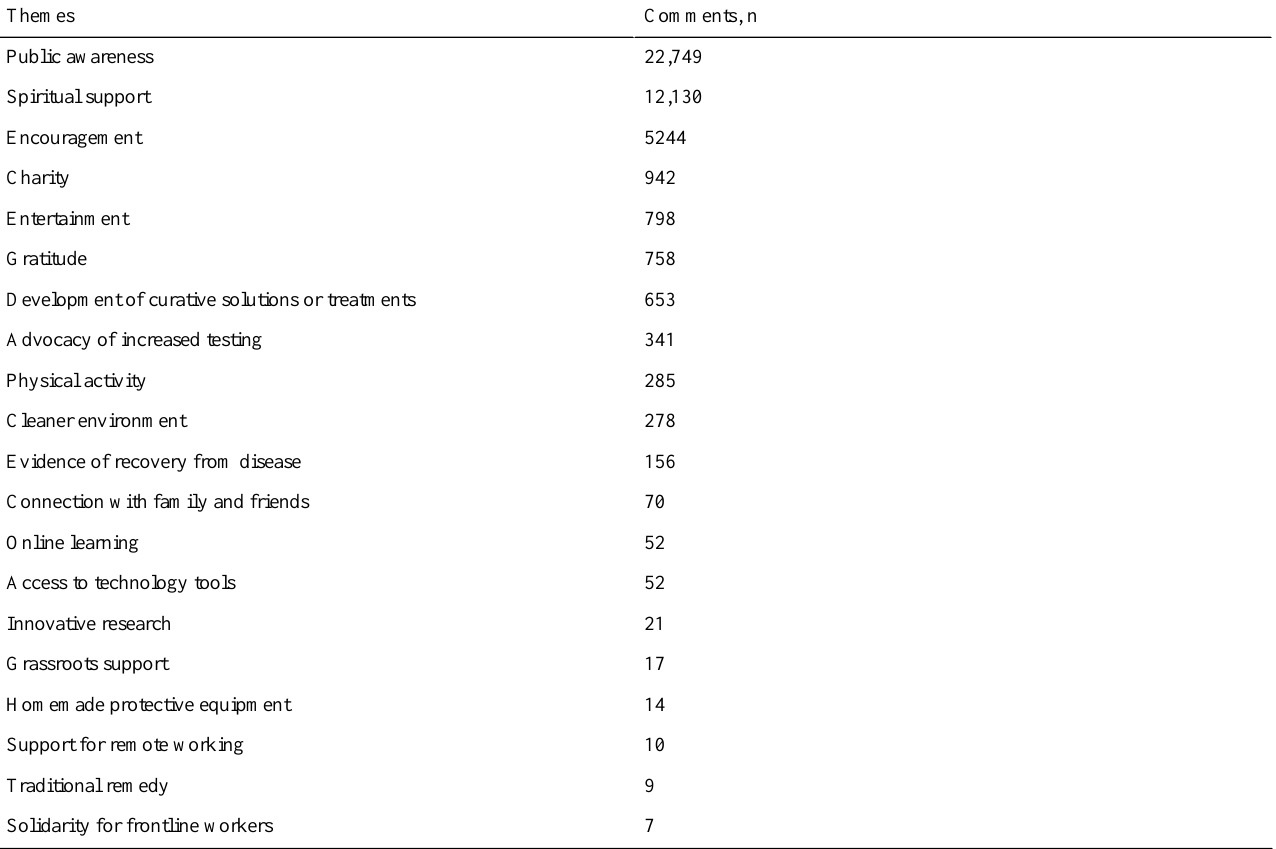
Table 9. Positive themes and the corresponding number of